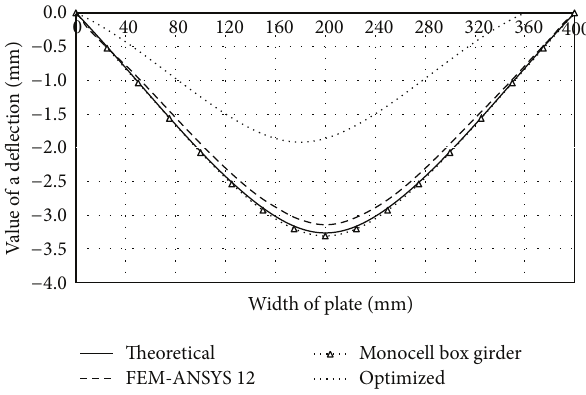
Figure 5: Comparative diagram of deflection of the left vertical girder plate